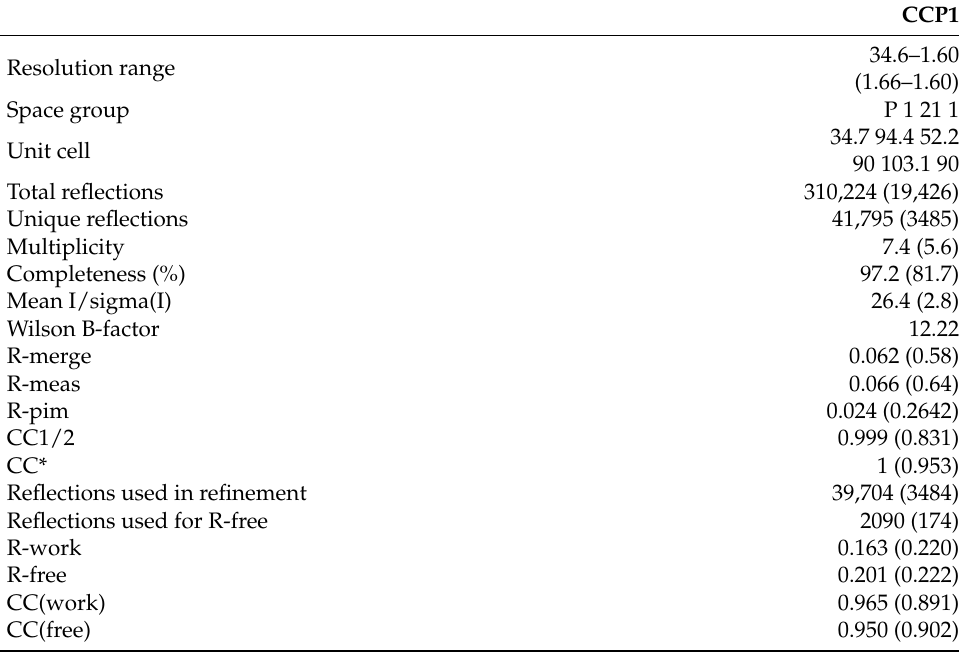
Table 1. Crystallization data collection and refinement statistics. Statistics for the highest-resolution shell are shown in parentheses.